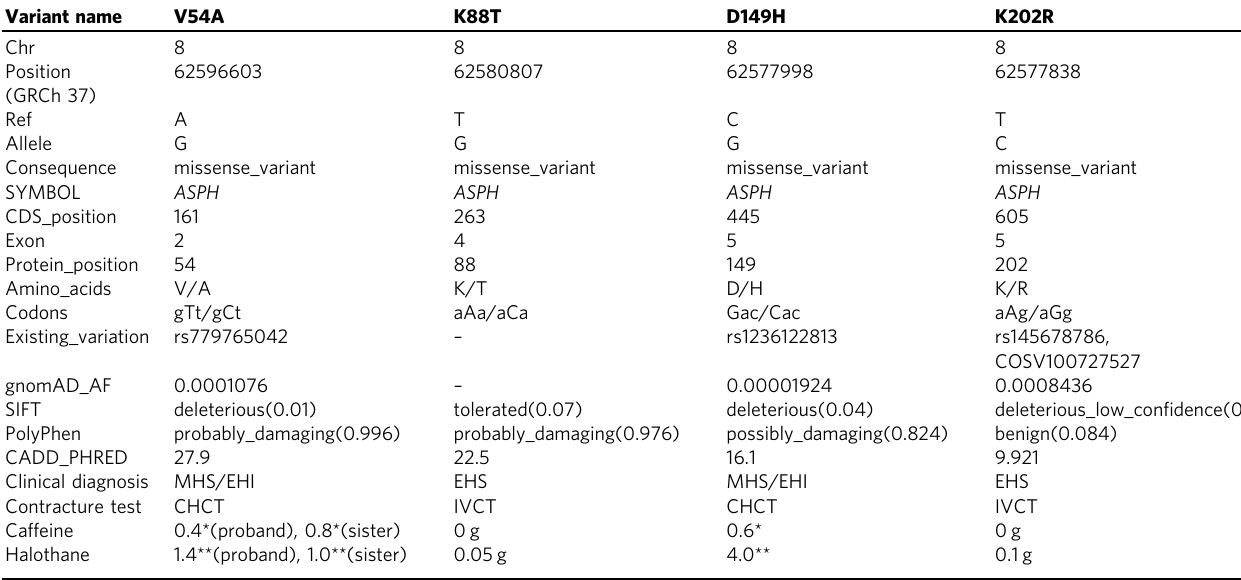
Table 1 Identi fi cation of rare, pathogenic ASPH variants in four families with